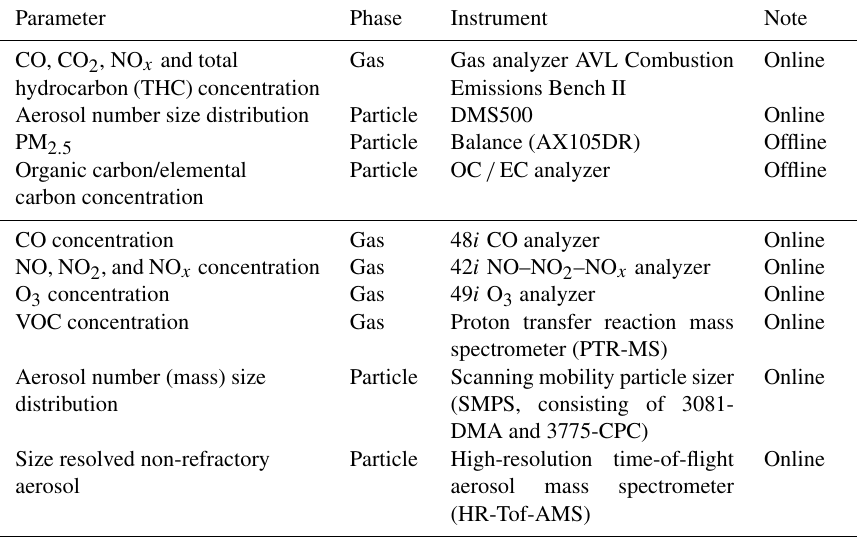
Table 2. Overview of all instruments used to measure the gas- and particulate-phase pollutants in the experiments. Parameter